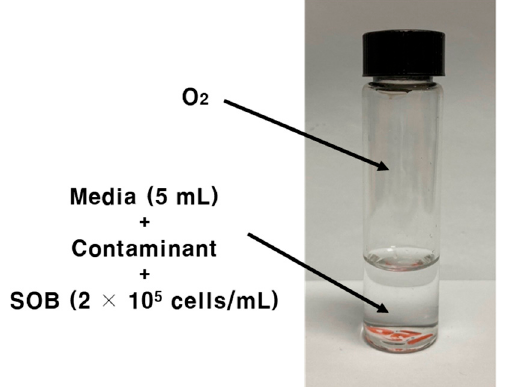
Figure 1. A SOB toxicity test kit. This 25 mL glass-vial-based SOB kit consists of 2 × 10 5 cells/mL of initial cell density and 5 mL of media. Headspace and media are purged with oxygen. Incubation is conducted in a shaking incubator with 120 rpm mixing intensity at 32 °C for 30 min.